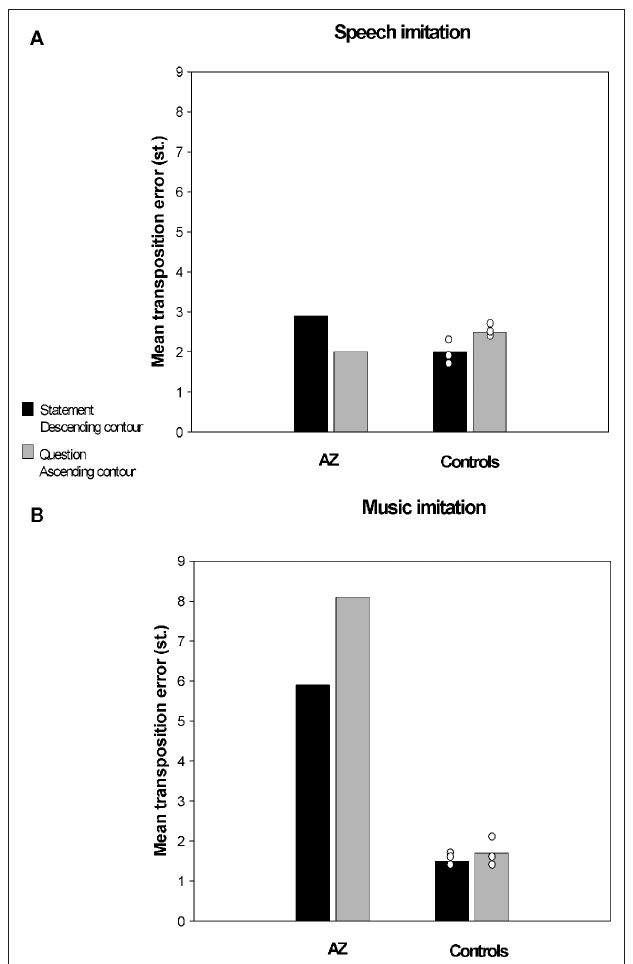
FiguRe 3 | imitation of pitch intervals by a poor-pitch singer (AZ) and three matched control participants, (A) in spoken utterances and (B) in a musical context (i.e., singing). Accuracy in terms of absolute pitch (transposition error)